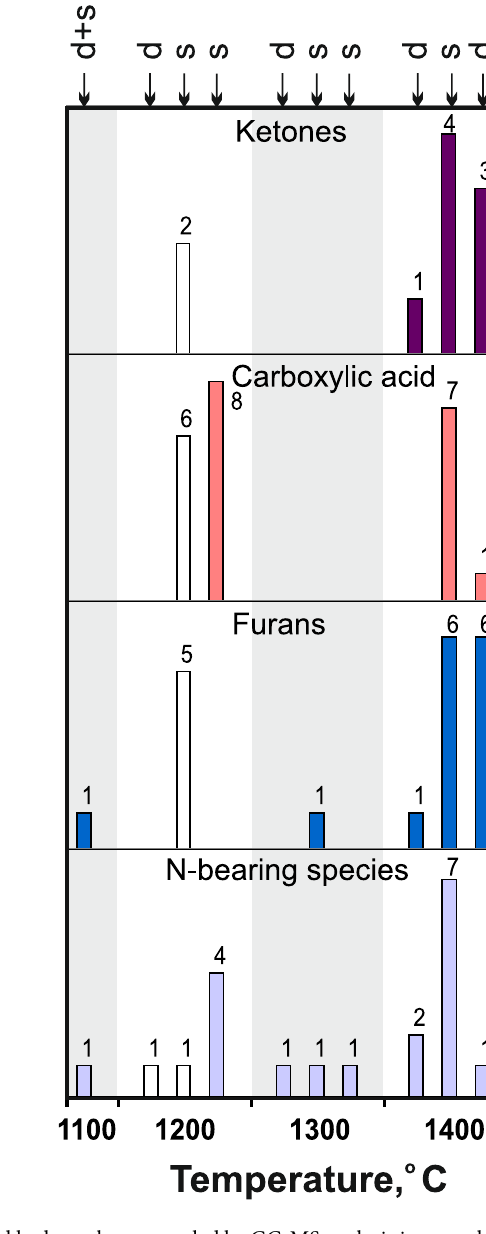
Figure 3. Diversity of alkanes, alkenes, and oxygenated hydrocarbons revealed by GC-MS analysis in quenched C-O-H-N fluids at 6.3 GPa, 1100–1400 °C, MMO-buffered f H 2 and run durations ≥ 2 hours. White columns are samples obtained in Au capsules. Letter symbols are same as in Fig.